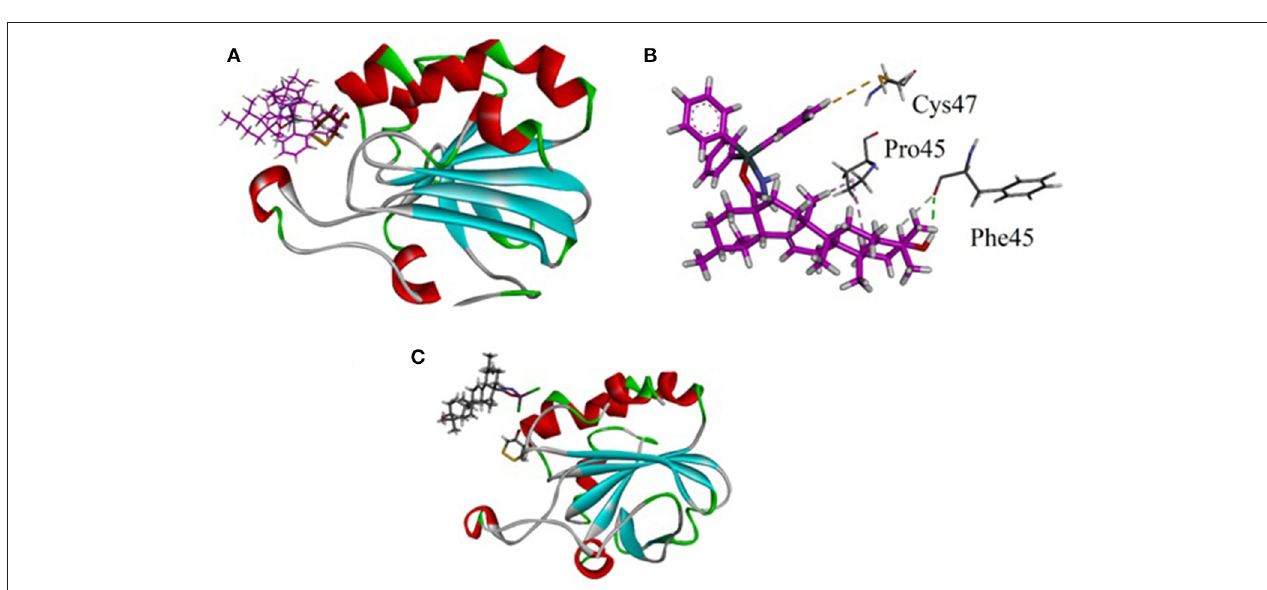
FIGURE 10 | (A) Lowest energy bonding pose of LTP superposed on DTT into the binding site of 3MNG; (B) Close-up view showing molecular interactions exhibited by LTP (purple); (C) The binding mode of LSC exhibited poor antioxidant activity.